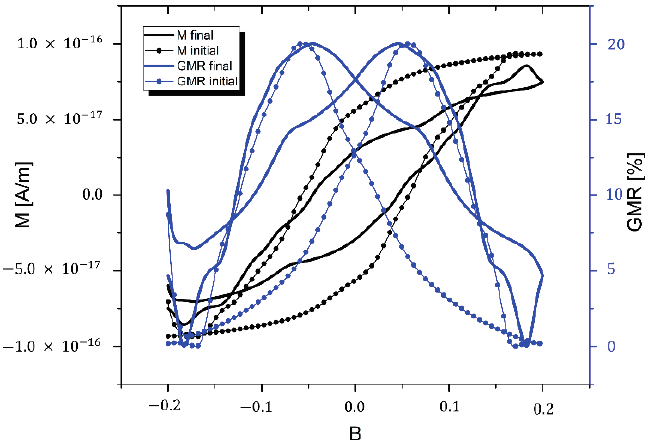
Figure 7. Simulated magnetization curves of the final configuration of the hybrid SD-MD simulation presented in Figure 6c (black line) and, for comparison, the magnetization curve of the initial configuration shown in Figure 6a (black dots). A rough estimate of the GMR properties of the system has been calculated by means of equation 12 (initial configuration with blue dots and final configuration with blue line) for an effect amplitude (cid:1827) according to previous experimental investigations